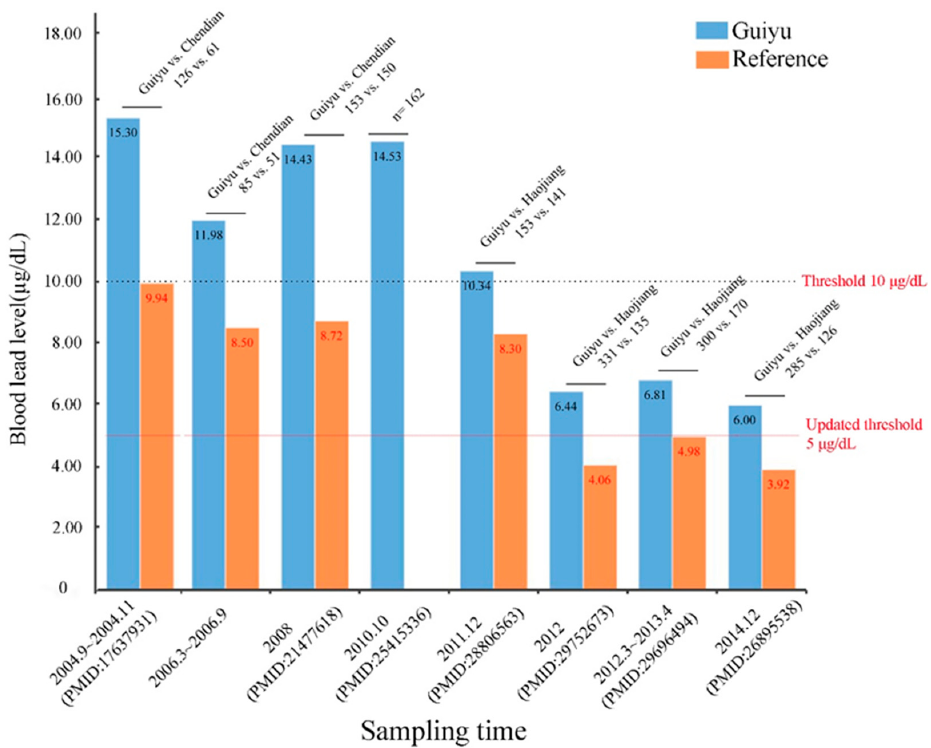
Figure 2. BLLs of children from Guiyu and reference sites from 2004 to 2014; number of children recruited from two groups depicted in each bar (PMID, NCBI PubMed identifier, a standard identifier for an article in PMC).